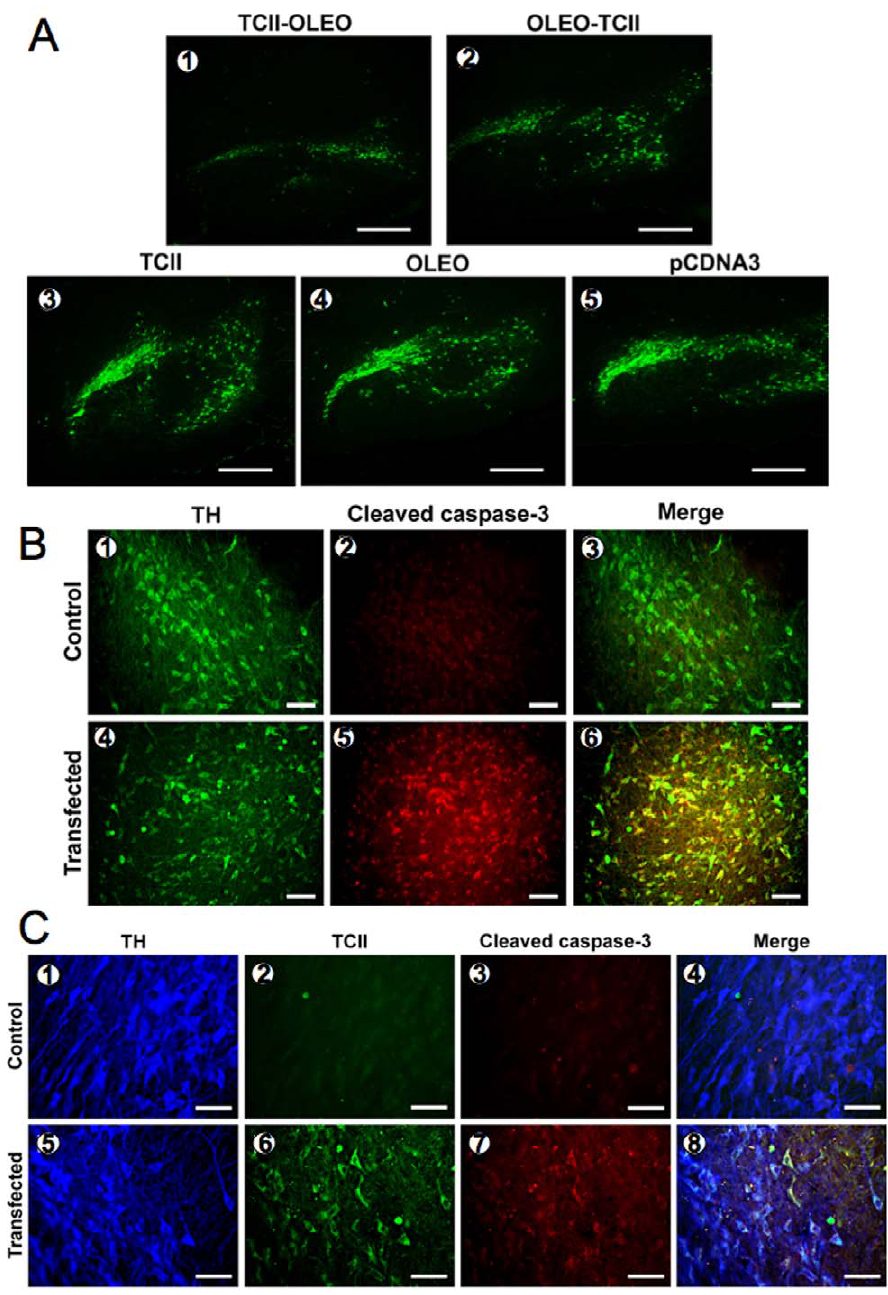
Figure 5. Apoptosis of tyrosine hydroxylase (TH) immunoreactive cells in the substantianigra of rats transfected with several plasmids. A: TH-immunoreactive neurons after transfection. The neurons were transfected with NTS-polyplex with one of the following plasmids, pCMV-TCII-OLEO coding for transcobalamin-oleosin (TCII-OLEO, 1), pCMV-OLEO-TCII coding for oleosin-transcobalamin (OLEO-TCII, 2), pCMV-TCII coding for transcobalamin II (TCII, 3), pCMV-OLEO coding for oleosin (OLEO, 4), and the pCDNA3, the empty plasmid (5). Mesencephalon slices (40 m m) were immunostained at 2-month after transfection with a mouse monoclonal antibody to TH and a donkey antimouse IgG fluorescein labeled. Representative micrographs of sagital section of the rat mesencephalon are presented. Calibration bars=200 m m. B: Apoptosis in TH- immunoreactive neurons after transfection with the plasmid pCMV-TCII-OLEO. Representative micrographs of the substantia nigra (with double immunostaining at 15-day after transfection) are presented. The primary antibodies were a mouse monoclonal antibody to TH, and a rabbit polyclonal antibody to cleaved Caspase-3. The secondary antibodies included a donkey anti-mouse IgG FITC labeled (1 and 4), and a donkey anti- rabbit IgG rhodamine labeled (2 and 5). Representative micrographs of coronal section of control substantia nigra (1–3) and transfected substantia nigra (4–6) of the same rat are presented. Scale bars=50 m m. C: Apoptosis in TH immunoreactive neurons expressing the TCII-OLEO chimera. Representative micrographs of the substantia nigra with triple immunostaining at 15-day after transfection. The primary antibodies were a mouse monoclonal antibody to TH, a goat polyclonal antibody to TCII, and a rabbit polyclonal antibody to cleaved Caspase-3. The secondary antibodies were a donkey anti-mouse IgG AMCA labeled (1 and 5), a donkey antigoat IgG fluorescein labeled (2 and 6), a donkey anti-rabbit IgG rhodamine labeled (3 and 7). Representative micrographs of coronal section of control substantia nigra (1–4) and transfected substantia nigra (5–8) of the same rat are presented. Scale bars=50 m m.